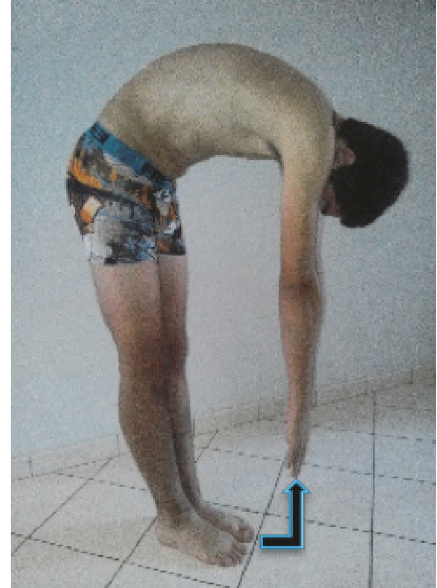
Figure 4: Hand-to-ground distance (in cm) tested before and after dry immersion. The movement is progressive and in sagittal plan without compensation. Legs are totally in extension with both feet tied. The goal is to show a restriction of spine mobility in flexion